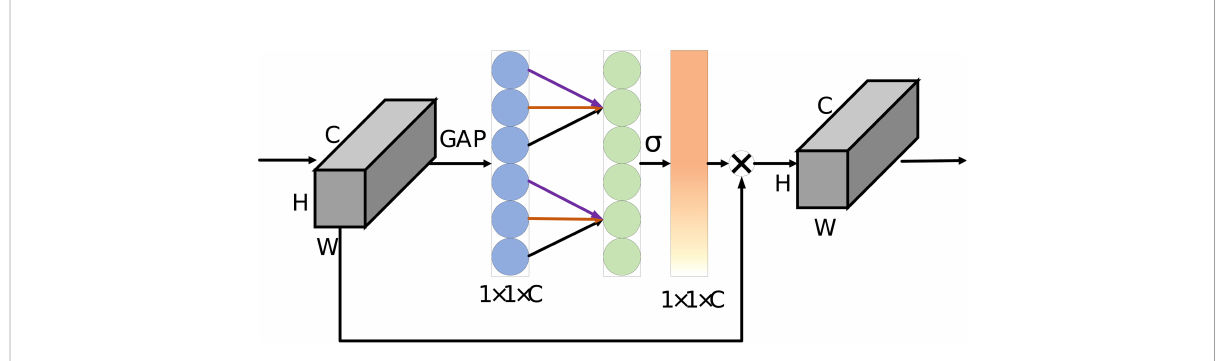
FIGURE 4 The ECA module takes the C×H×W feature map as input, compresses features through global average pooling (GAP), and uses 1×1×C 1- dimensional convolution with kernel size of 3 to obtain the channels ’ attention weight. Finally, the attention map is obtained by Dot between the attention weight obtained and the original input of the module. s is Sigmoid